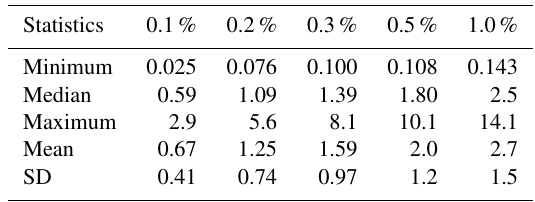
Table 2. Ranges, medians and means with SDs of the CCN concen- tration (in × 10 3 cm − 3 ) at supersaturations of 0.1%, 0.2%, 0.3%, 0.5% and